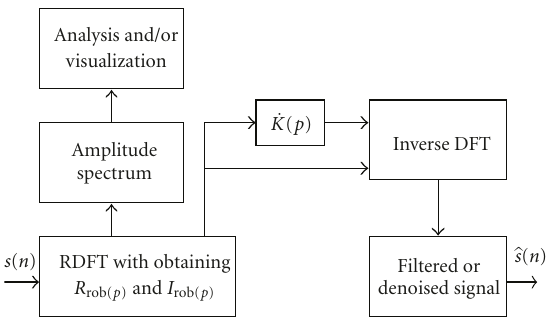
Figure 1: Block diagram for signal processing approach based on RDFT.